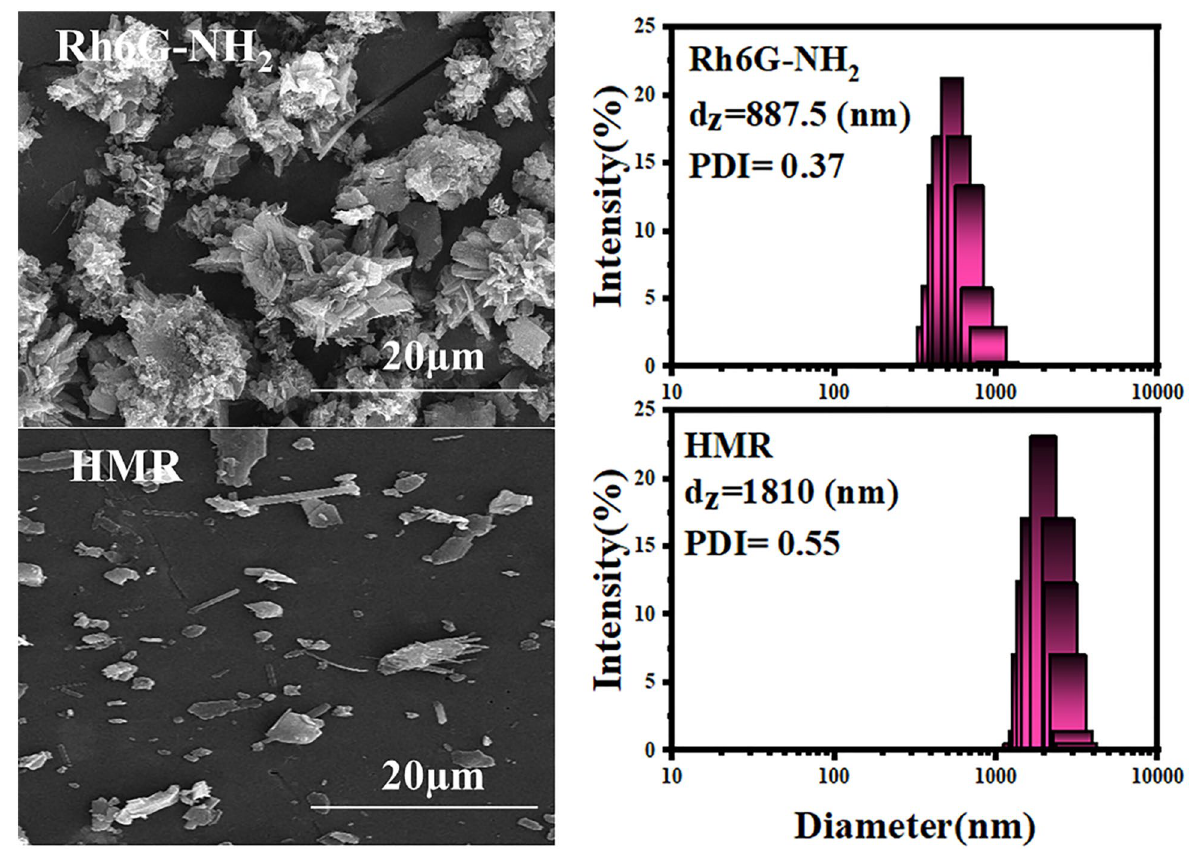
Figure 3. FE-SEM images and DLS results of Rh6G-NH 2 and HMR.